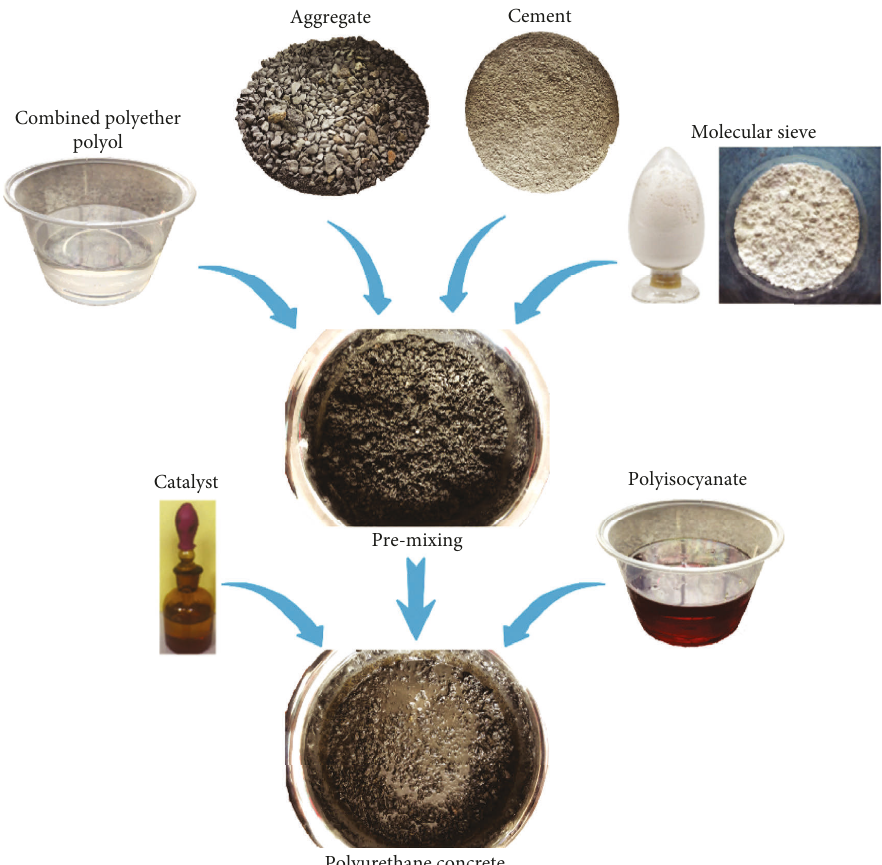
Figure 3: Flow diagram for the polyurethane concrete preparation process.